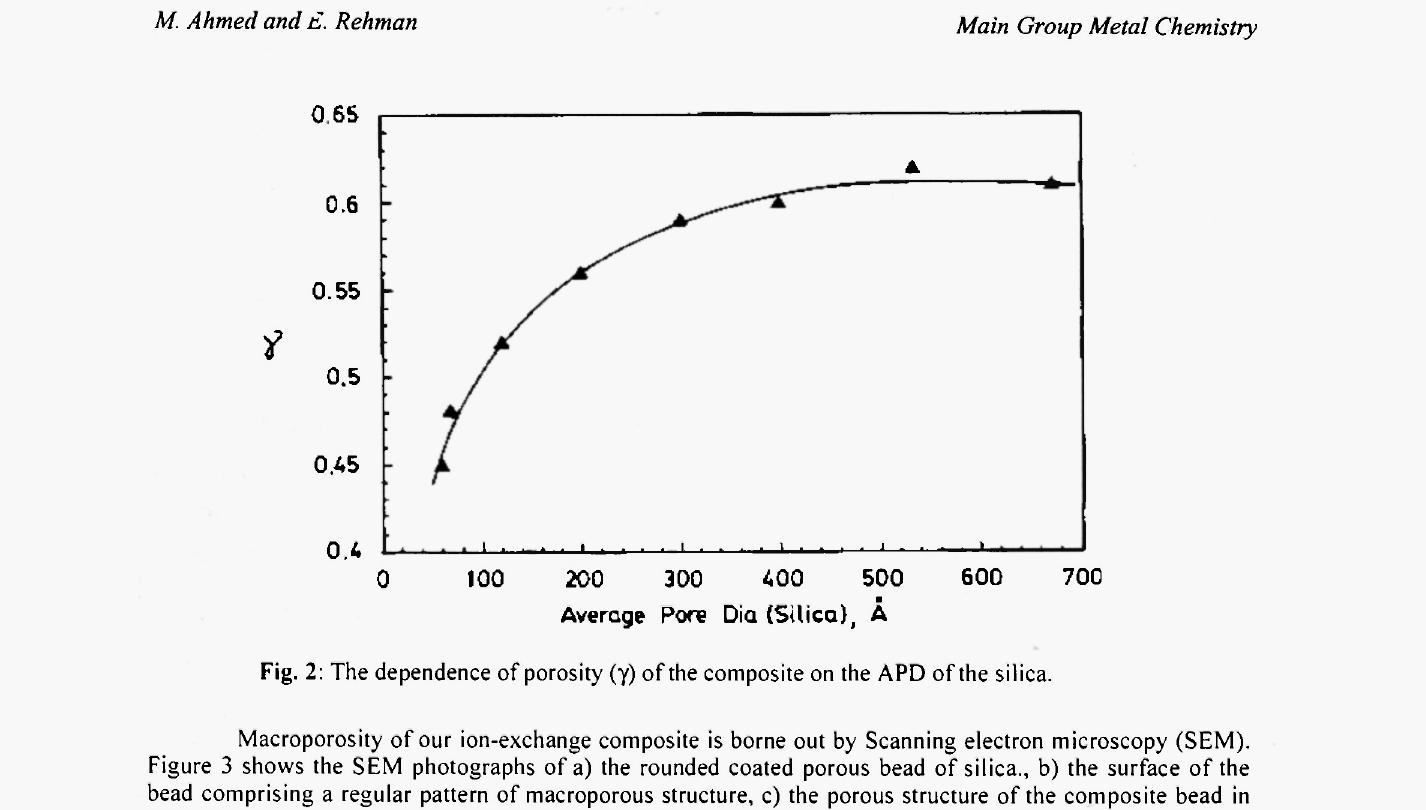
Fig. 2: The dependence of porosity (γ) of the composite on the APD of the silica. Macroporosity of our ion-exchange composite is borne out by Scanning electron microscopy (SEM).